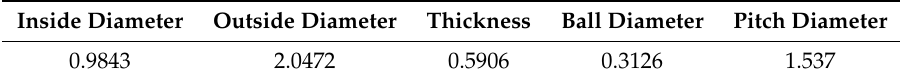
Table 2. Bearing specification table (inches).